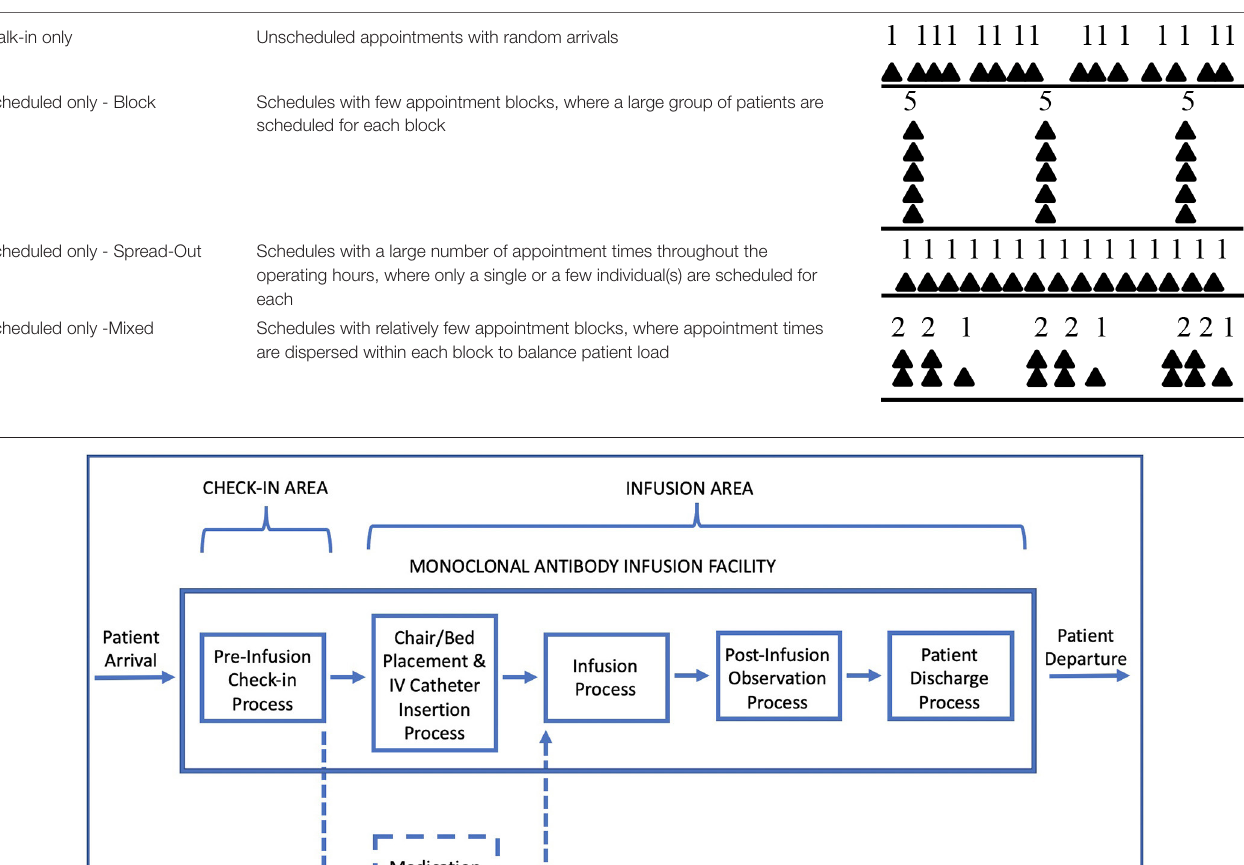
TABLE 1 | Different appointment types considered in our analysis.